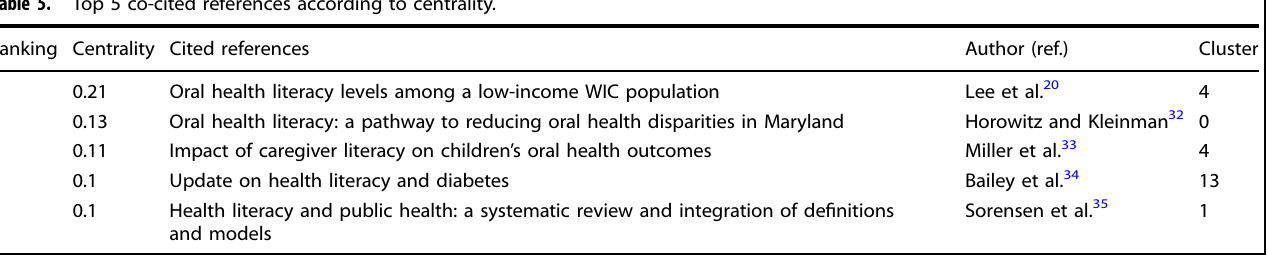
Table 5. Top 5 co-cited references according to centrality.